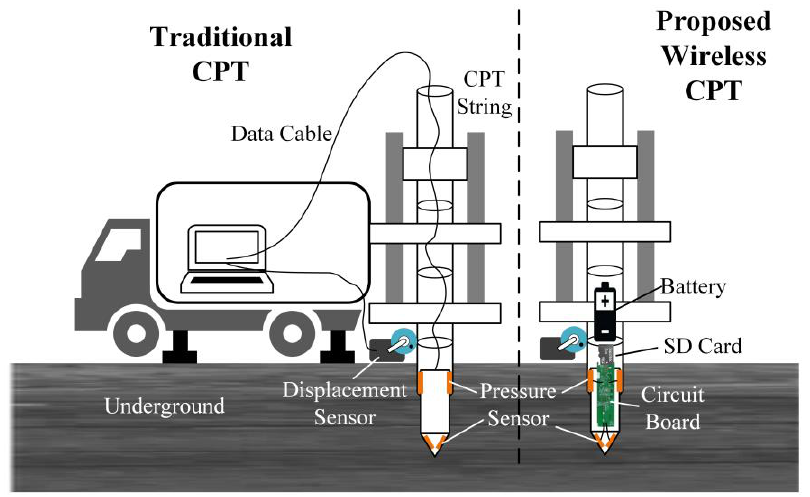
Figure 1. Cone penetration vehicle.